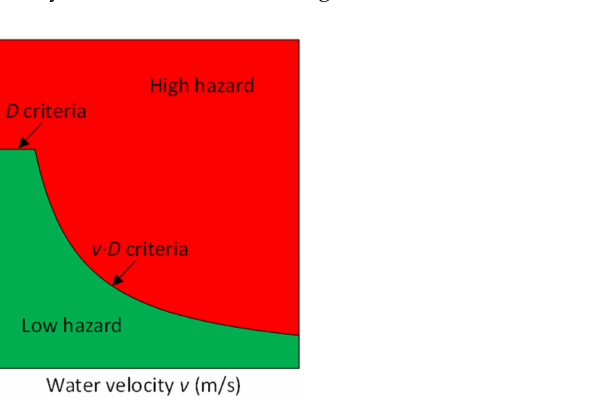
Figure 4. Hazard criteria adopted for the assessment of human stability in sewer pipes during dry weather